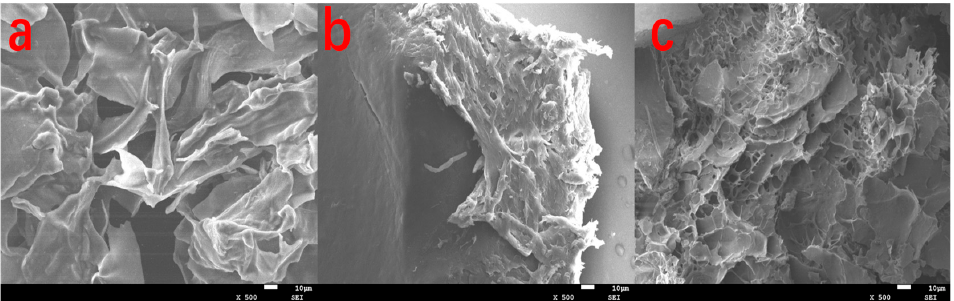
Figure 2. SEM images from KGM hydrogel ( a ), NIPAM Hydrogel ( b ), and IPN hydrogel ( c